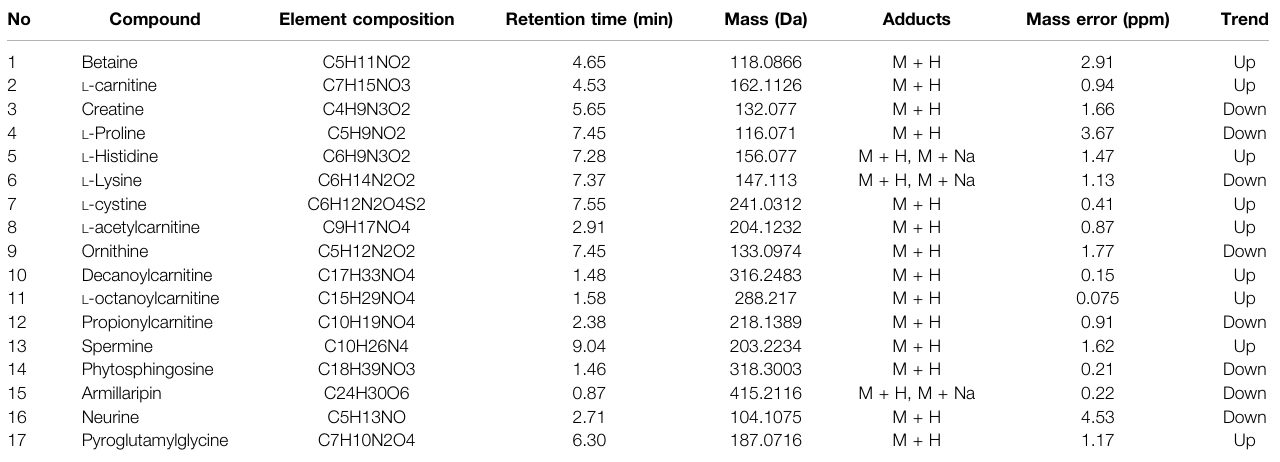
TABLE 1 | Identi fi cation of biomarkers in the oral disease group and the healthy control group.